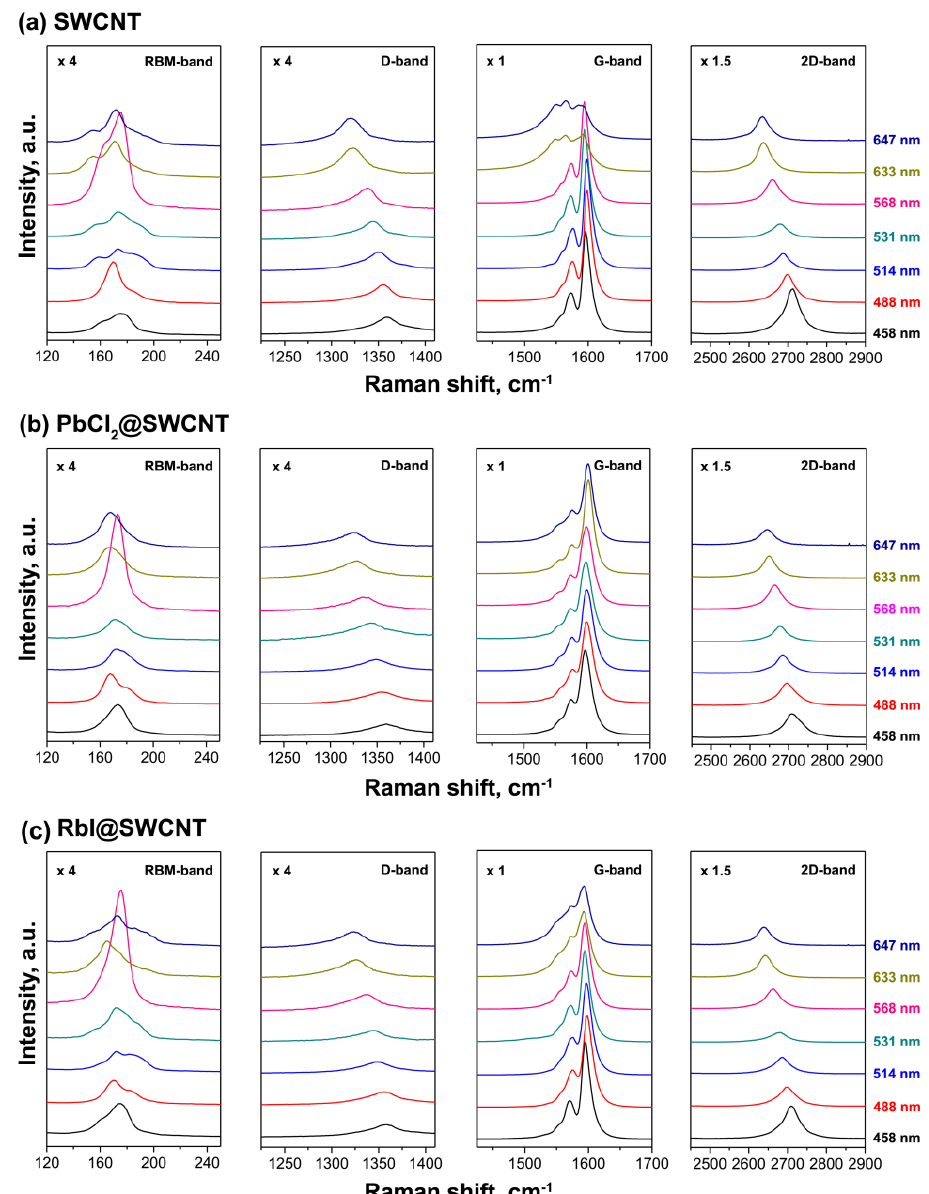
Figure 4. The Raman spectra of the pristine SWCNTs ( a ) [168] (reprinted with permission from [168], copyright 2019 Wiley-VCH Verlag GmbH & Co. KGaA, Weinheim), PbCl 2 @SWCNT ( b ) (reproduced from M. V. Kharlamova et al. Revealing the doping effect of encapsulated lead halogenides on single-walled carbon nanotubes, Appled Physics A, V. 125, article number 320, 2019, Springer Nature [145]) and RbI@SWCNT ( c ) [168] (reprinted with permission from [168], copyright 2019 Wiley-VCH Verlag GmbH & Co. KGaA, Weinheim).